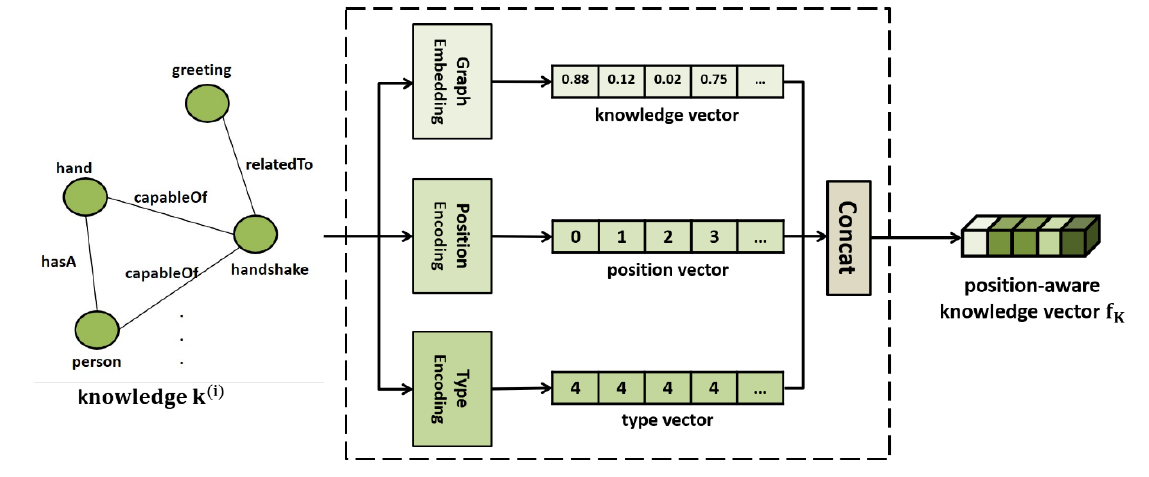
Figure 7. Knowledge embedder.